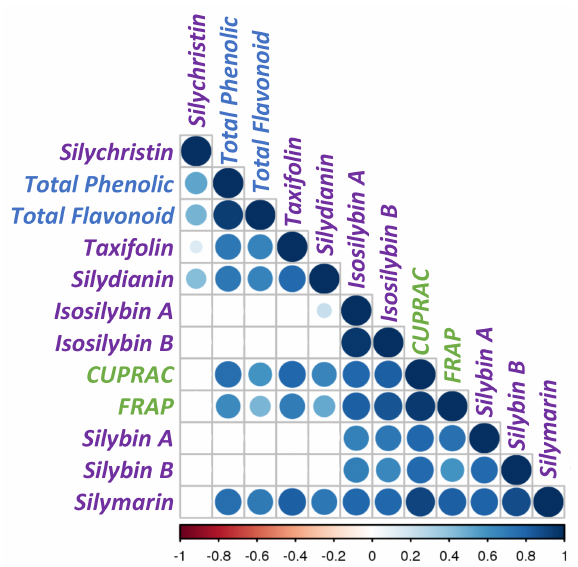
Figure 6. Correlogram analysis between phytochemical profiles of Silybum marianum extracts analyzed in this study and their antioxidant activities. Positive correlations are displayed in blue and negative correlations in red. Color intensity and the size of the circles are proportional to the correlation coefficients. Below the correlogram of flavonolignans and antioxidant tests, the legend color shows the correlation coefficients and the corresponding